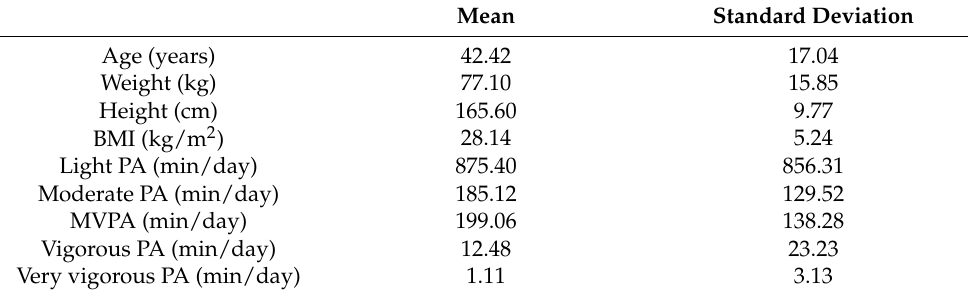
Table 1. Characteristics of the sample (n =